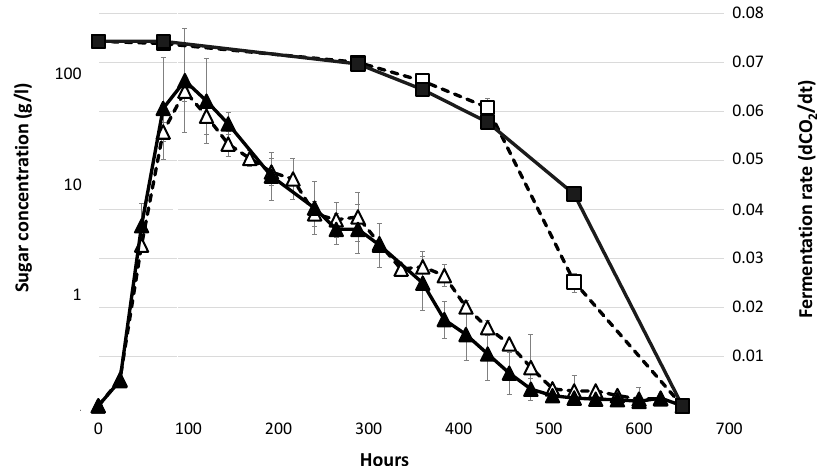
Figure 1. Fermentation kinetics and sugar consumption of EC1118 during growth in FSJ (straight lines) and SJ (dotted lines). Black triangles: fermentation rate in FSJ; white triangles: fermentation rate in SJ; black squares: residual glucose in FSJ; white squares: residual glucose in SJ. Data are means ± standard deviation of three independent biological replicates.